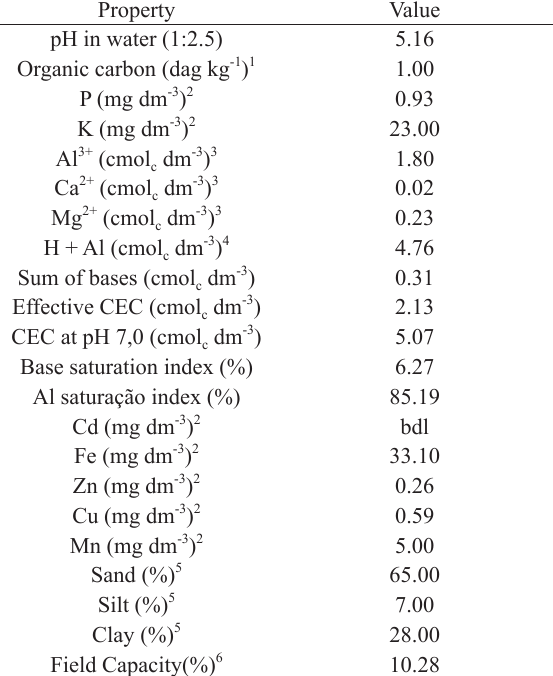
Chemical and physical properties of the soil (Red-Yellow